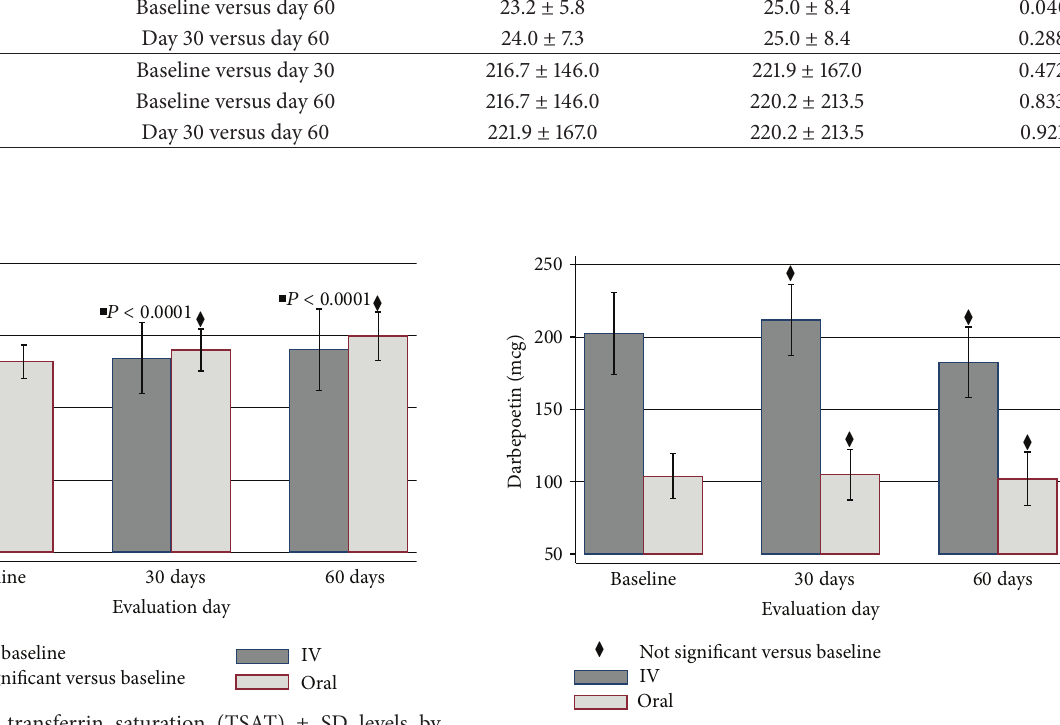
Figure 5: Darbepoetin alfa (mcg) ± SD utilization by treatment group over duration of